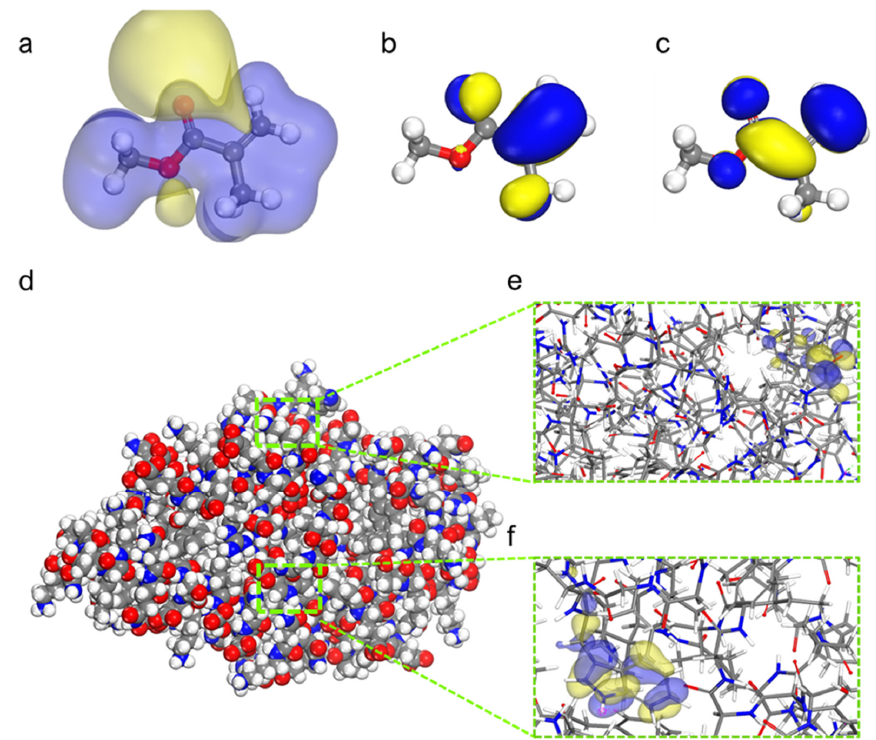
Figure 3. ( a ) Electrostatic potential, ( b ) HOMO, and ( c ) LUMO isosurfaces of MMA after geometry optimization using the B3LYP hybrid functional. ( d ) Optimized structure, ( e ) LUMO, and ( f ) HOMO isosurfaces of CagA after geometry optimization with DFTB+ with 3ob Slater − Koster